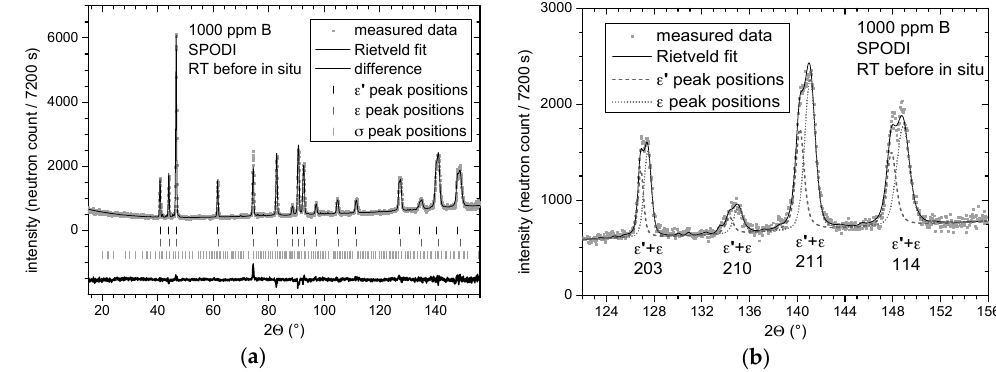
Figure 2. ( a ) Diffractogram measured at RT (in ST condition) on the sample 1000 ppm B. Two hcp phases and the tetragonal σ phase were needed to describe the diffraction data. The graph ( b ) shows